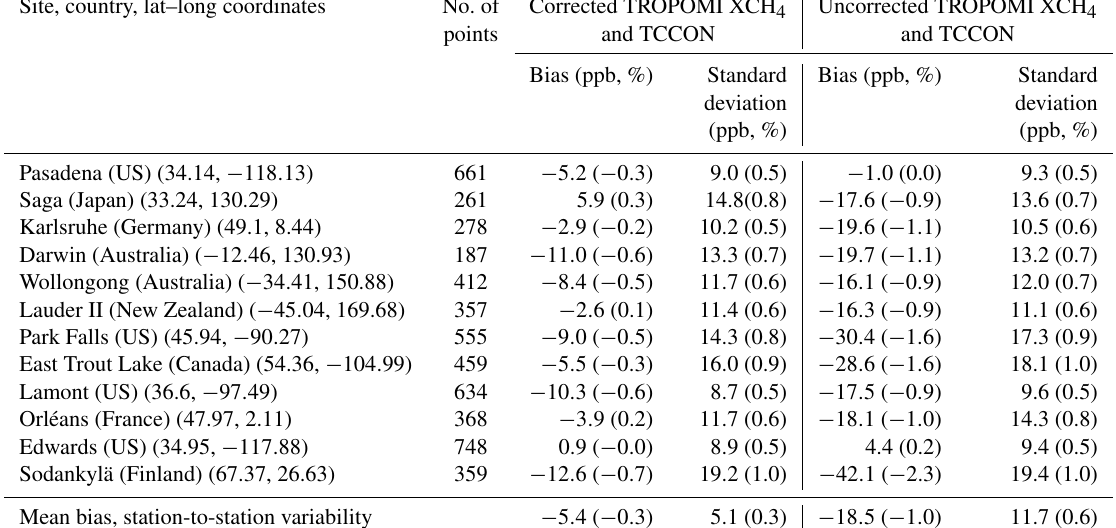
Table 3. Overview of the validation results of TROPOMI XCH 4 land measurements with measurements from the TCCON network at selected stations. The table shows the number of collocations, mean bias and standard deviation for each station and the mean bias for all stations and the station-to-station variability. Results are shown for TROPOMI XCH 4 with and without the albedo bias correction applied. Site, country, lat–long coordinates No.